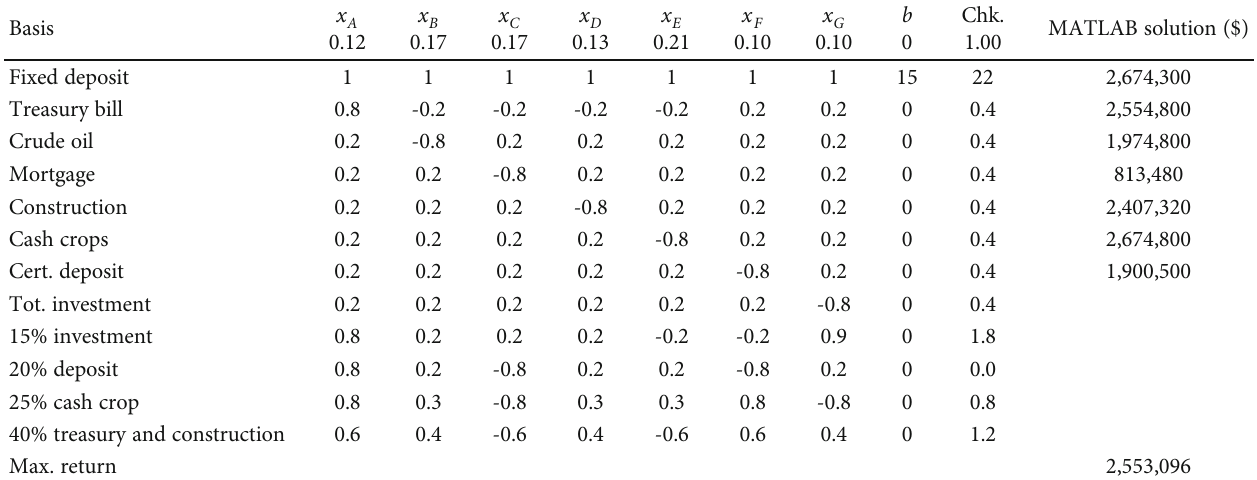
Table 2: The simplex method and MATLAB solution in fi nding the optimal investment in a portfolio mix for the fi rm. Basis Treasury